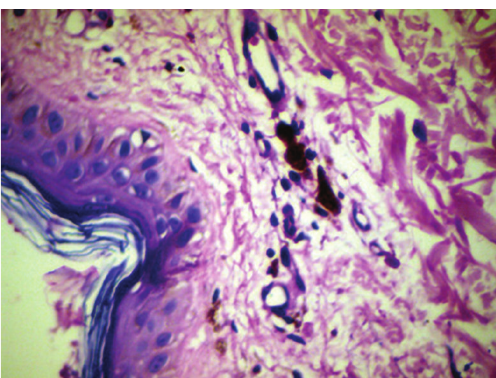
Figure 3: H&E section of the pigmented area of upper back of case 2 showing atrophic epithelium overlying a moderately collagenous connective tissue. Melanocytes present in the dermis. Inflammatory cells are conspicuous by their absence (high